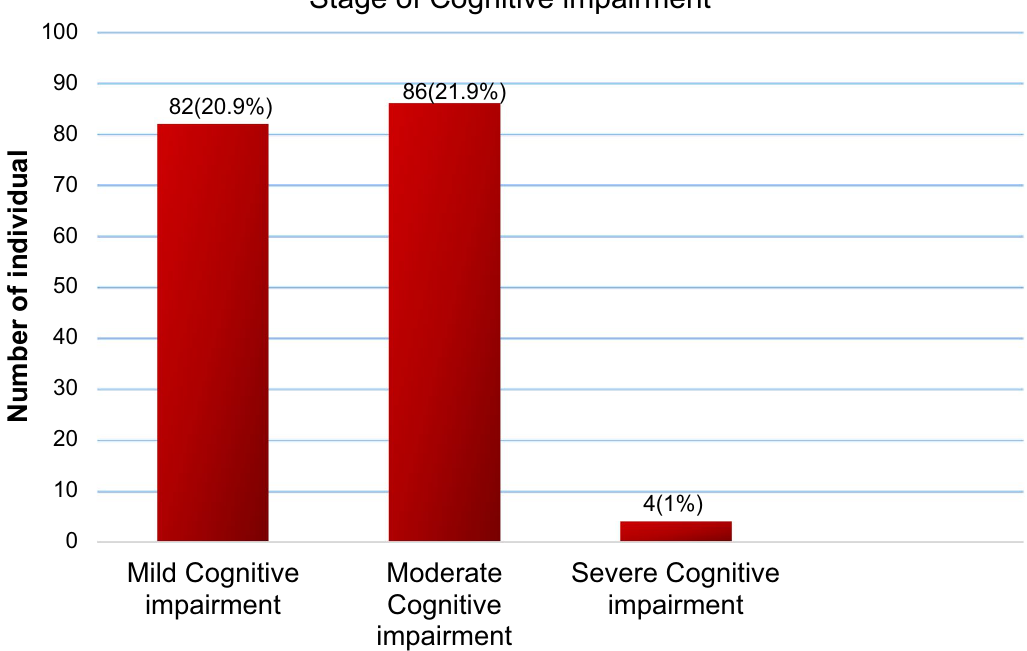
Figure 1. Stage of cognitive impairment among mature and older adults living in the community of Gondar town, Ethiopia,